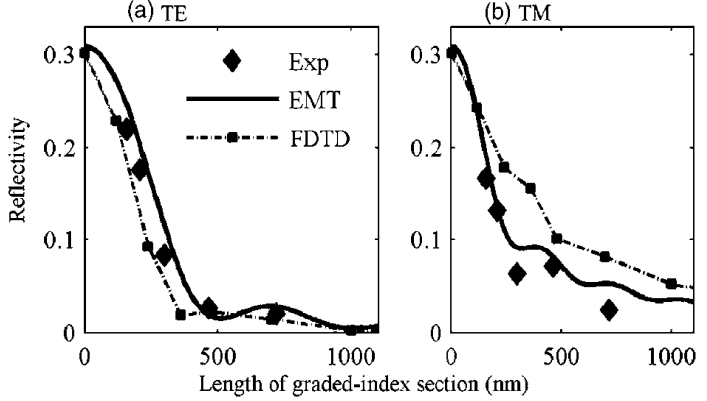
Figure 14. Comparisons between reflectivity calculated by EMT, FDTD, and experimental results for GRIN structures. Reprinted with permission from reference [40], Copyright 2007 Optical Society of